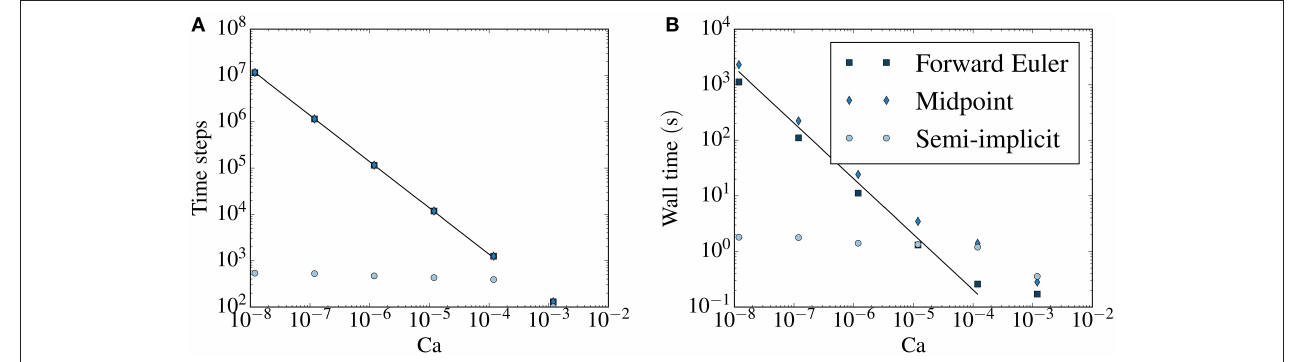
FIGURE 11 | (A) Number of time steps and (B) wall clock time required to simulate the Haines jump case at at different specified flow rates. In each simulation, the same volume of fluid (5% of the pore volume) flows through a network. Results from the forward Euler method (squares), the midpoint method (diamonds) and the semi-implicit method (circles) are shown. In (A,B) , the black lines are inversely proportional to Ca.